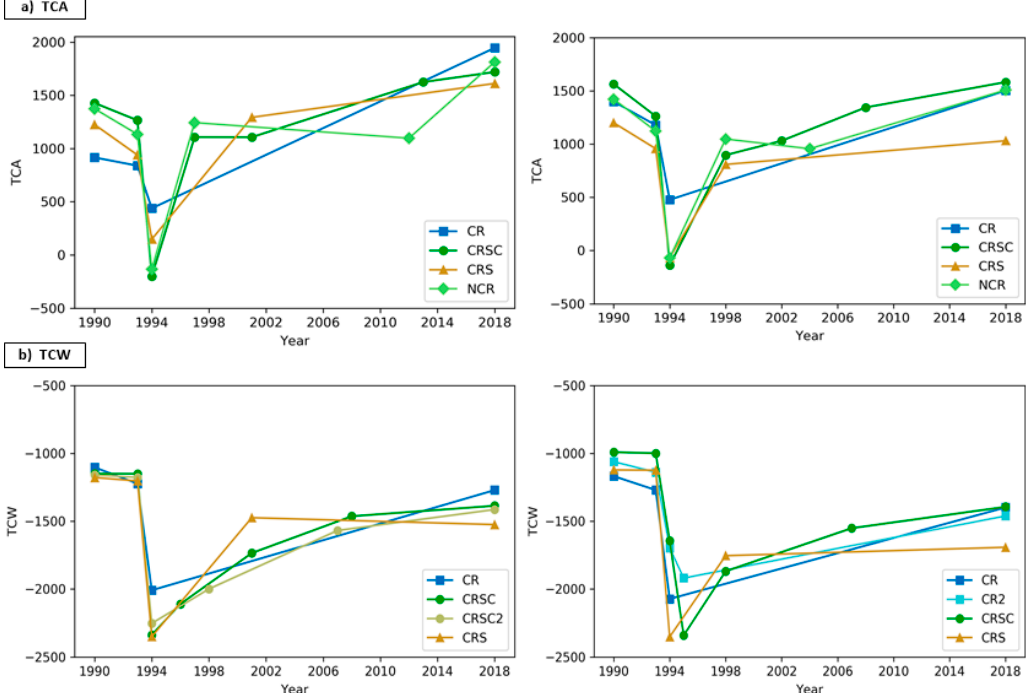
Figure 7. Time series of mean fitted trajectories for each category: ( a ) TCA and ( b ) TCW; Requena (left) and Yeste (right).